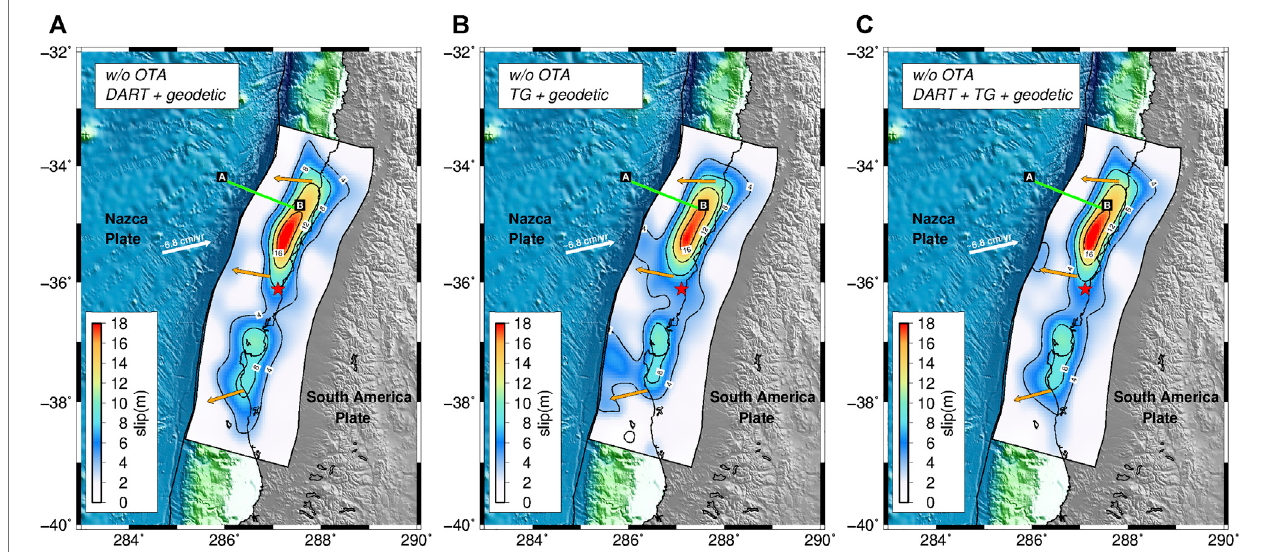
FIGURE 4 | Rupture models of the 2010 Maule earthquake. Slip models (4 m contour lines in black) are estimated by jointly inverting geodetic and DART data (A) , geodetic and tide-gauge data (B) , geodetic, DART, and tide-gauge data (C) . Red star represents the epicenter of the Maule earthquake; orange arrows represent the average slip directions (rake); green line represents the ILOCA track. All of the inversions have been performed without using OTA.